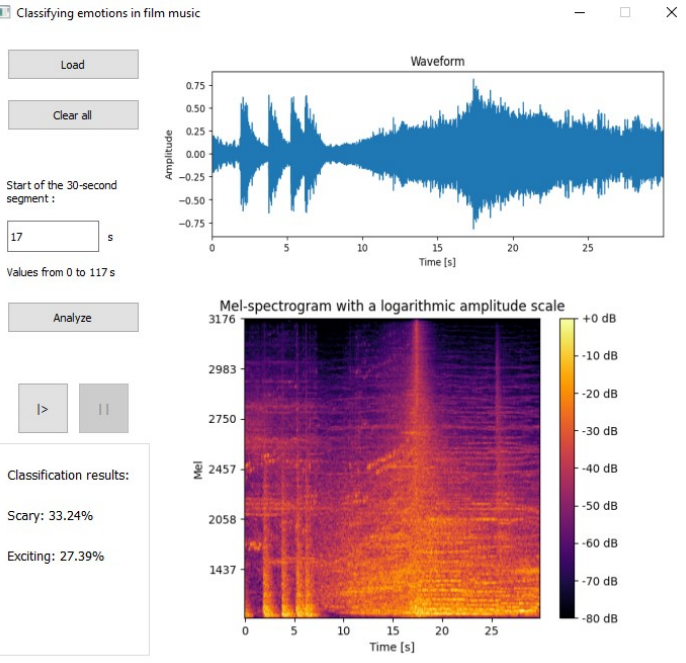
Figure 11. An example of the application interface showing the audio file loading. Its description (in Polish) denotes opening and loading a music file.